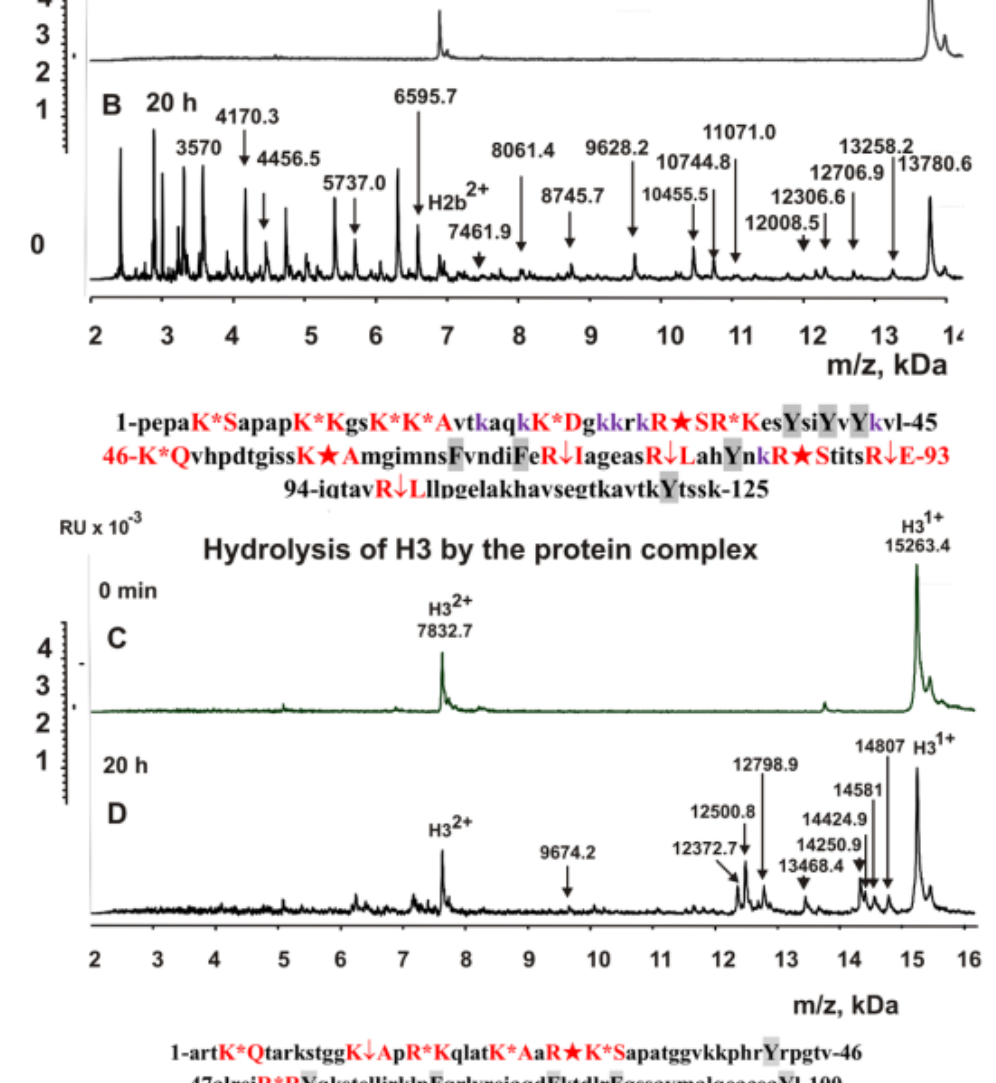
Figure 3. MALDI spectra correspond to 0.8 mg/mL H2B ( A , B ) and H3 histone ( C , D ) in the presence of sea cucumber stable complex (0.15 mg/mL or 7.5 × 10 − 8 M). Below the spectra, the protein sequences of histones H2B and H3 and the sites of their hydrolyses by the stable complex are shown. Major cleavage sites are indicated by large stars ( ★ ), moderate sites by arrows ( ↓ ), and minor sites by colons (:) ( A – D ). Aromatic residues of the protein sequence are marked in grey, after which no histone hydrolysis is observed. RU: relative values.